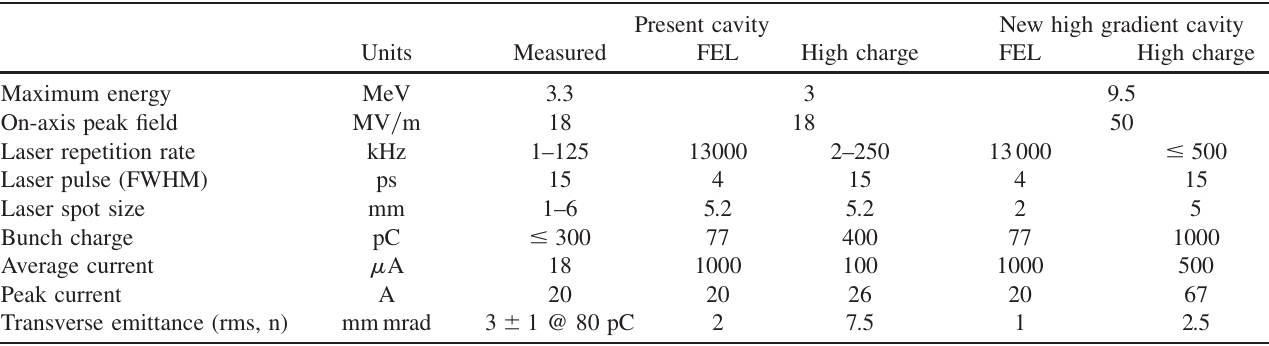
TABLE II. Measurement results and designed parameters of the FZD SRF